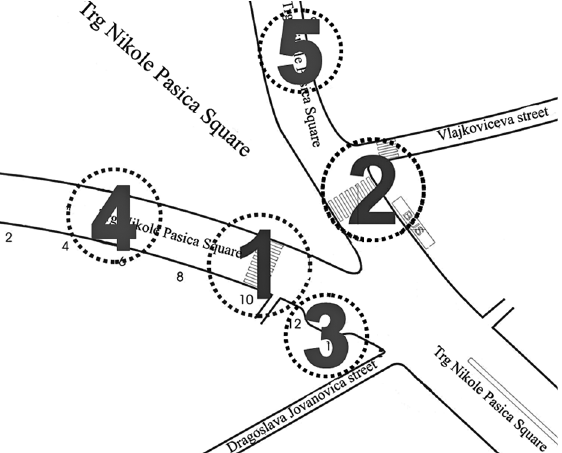
Fig. 7. The final rank of danger spots for